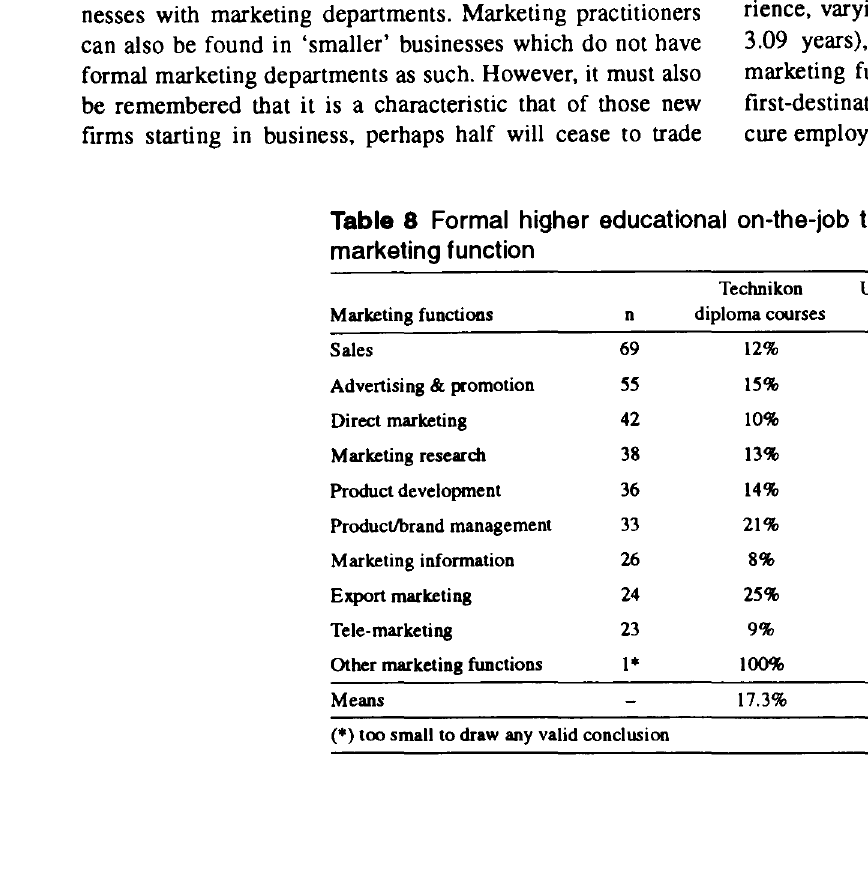
Table 8 Formal higher educational on-the-job training executed per marketing